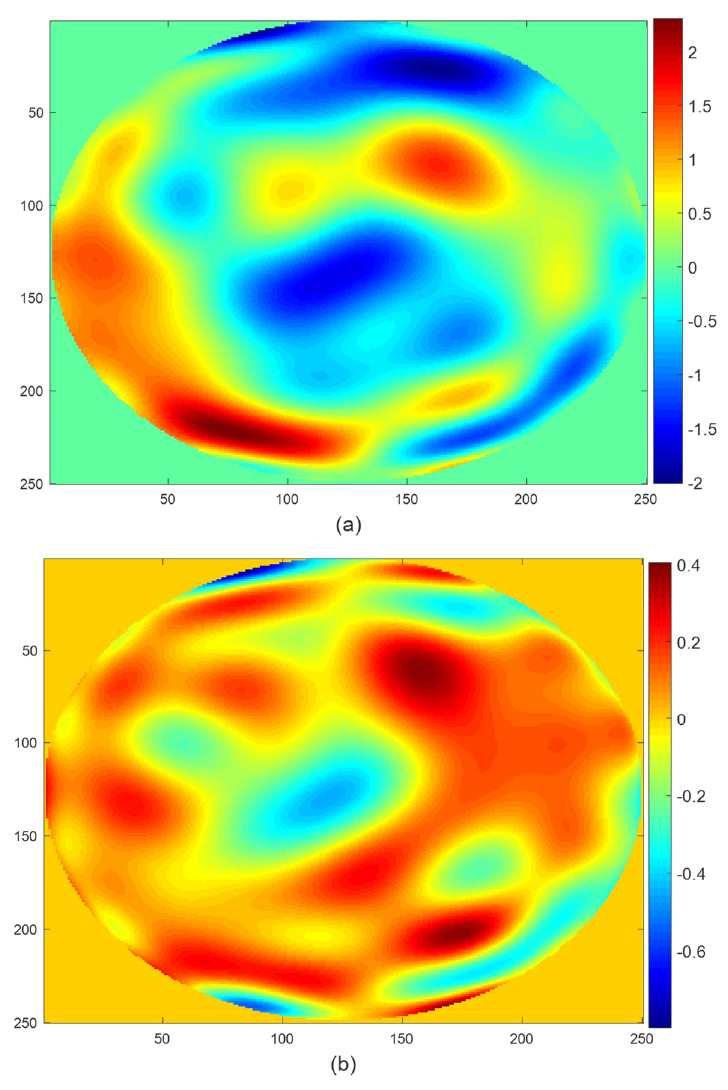
Figure 7. Wavefront detected with the WFS: ( a ) original and ( b ) residual wavefront after correction with the DM.